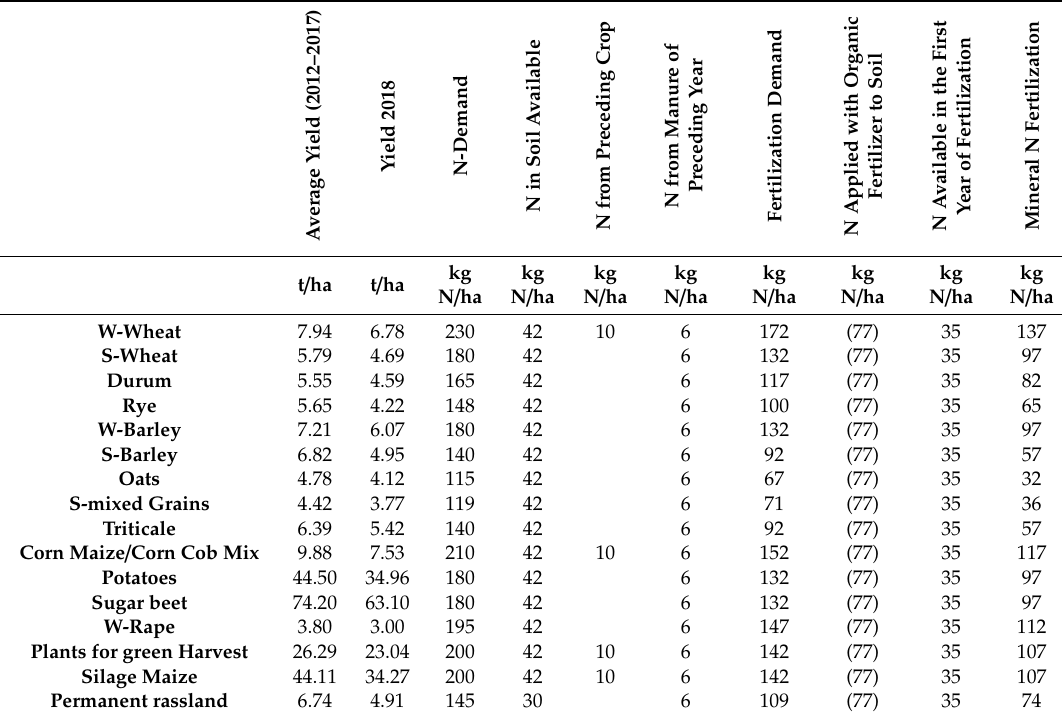
Table 1. Calculated nitrogen supply for di ff erent crops from available organic and mineral fertilization, according to average yields (2012–2017) and rough estimates on N mineralization based on regulations of the German Fertilization Ordinance [31].